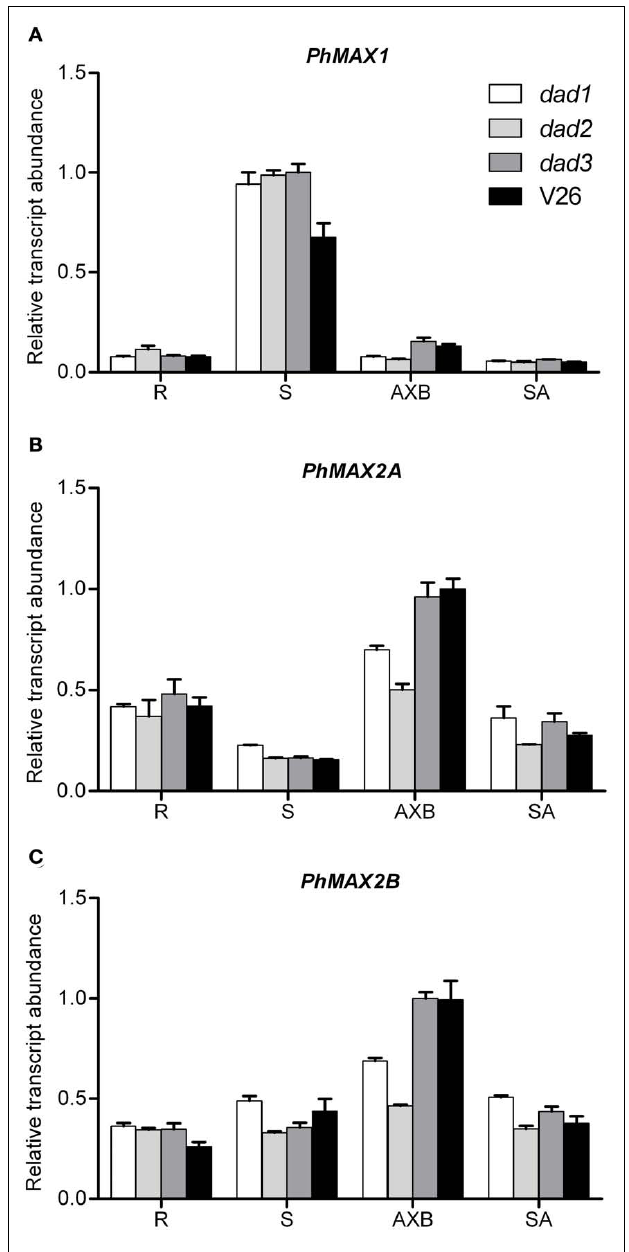
FIGURE 5 | Relative transcript abundance in 8-week-old wild-type and dad mutant petunia. Values are means ± SEM and indicate technical variation over triplicate reactions. R, fine roots; S, 2cm of stem above the cotyledons (nodes and internodes); AXB, axillary bud; SA, shoot apex. Relative transcript abundance as rescaled against the sample with the greatest expression for each gene (A) PhMAX1 , (B) PhMAX2A , (C) PhMAX2B